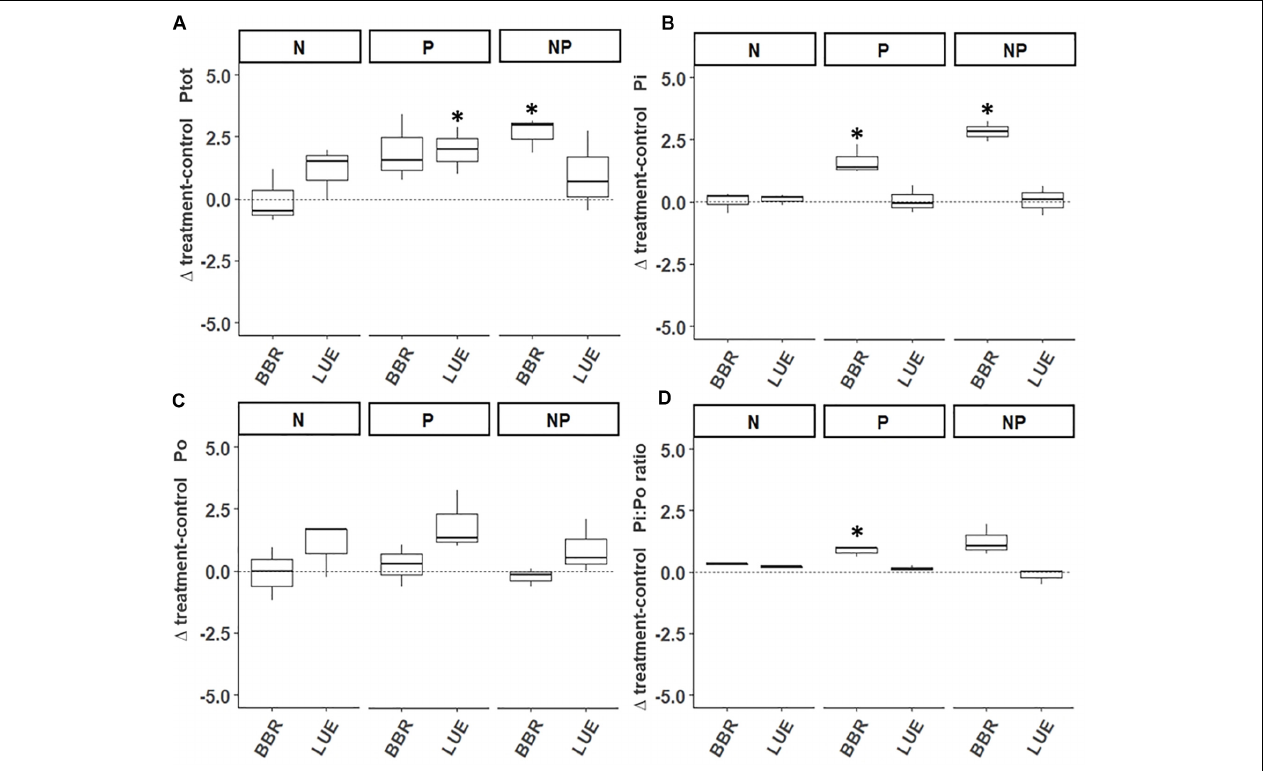
FIGURE 5 | Difference in phosphorus concentrations (mg P l-1) in xylem sap between fertilized trees (N, P, N+P) and non-fertilized trees (control) 14 days after application of 18O-enriched water. Differences are displayed separately for total phosphorus (Ptot, A ), inorganic phosphorus (Pi, B ), organic phosphorus (Po, C ) and the ratio of Pi to Po (D) . Asterisks above boxplots indicate differences significantly deviating from zero (i.e., the control). BBR = Bad Brückenau; LUE =